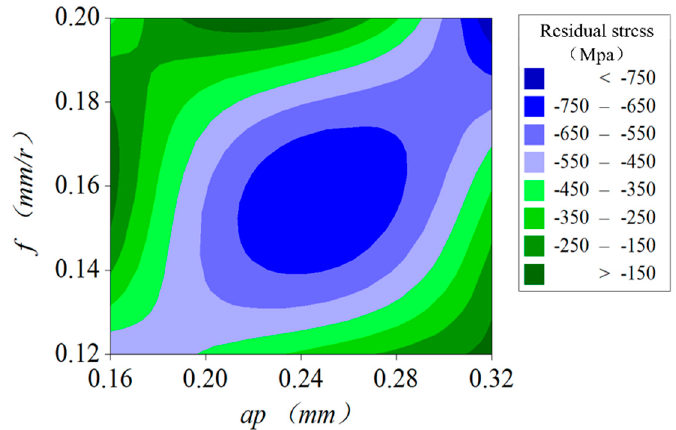
Figure 17. Single factor effect of cutting parameters on the surface residual stress.